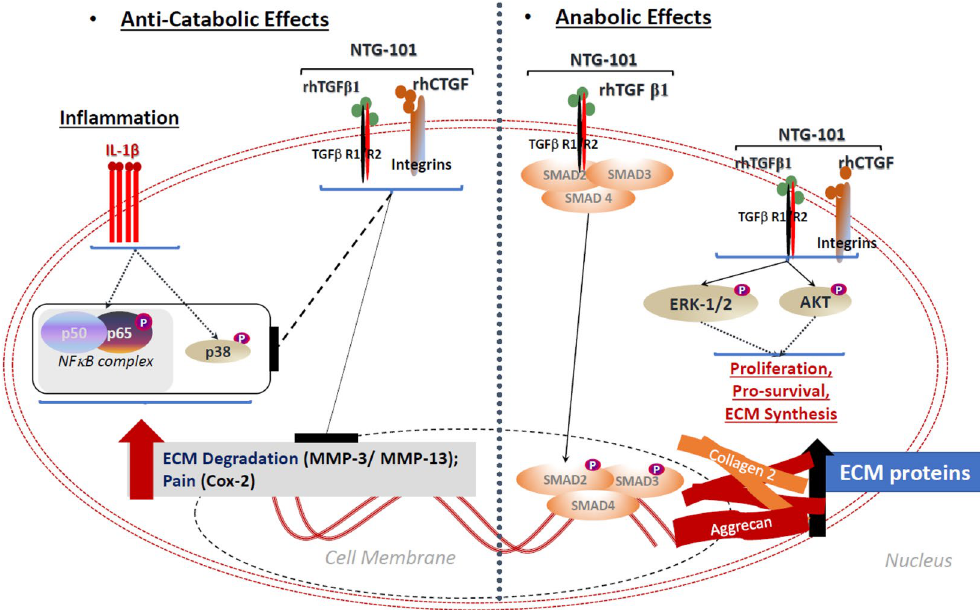
Figure 7. Model for mechanism of action (MoA) of NTG-101 in IVD-NP cells. Treatment with NTG-101 suppressed inflammation induced expression of matrix degrading enzymes (MMP-3. MMP-13), pain related enzyme, Cox-2 and expression of pro-inflammatory cytokines (IL-1β, IL-6 and IL-8) in rat, canine and human IVD NP cells in vitro and in vivo 27, 28 . Treatment with NTG-101 also suppressed phosphorylation of p38 and p65 subunit of NFκB complex, key regulators of inflammation in IVD-NP cells. Along with suppression of inflammation, NTG-101 also initiated ECM synthesis (Aggrecan, Col2A1), promoted cell survival and stemness in rat caudal IVD-NP post-injury. NTG-101 components, rhTGF-β1 and rhCTGF work synergistically under hypoxia resulting in regeneration of a degenerative disc. Combination of rhTGF-β1 and rhCTGF activates Smad-2/3 dependent signaling which regulate synthesis of GAG, PG and other important ECM molecules withing IVD-NP. Further, phosphorylation of Erk-1/2 (p42/44) and Akt in Smad-dependent or independent ways promote cell survival and proliferation in IVD-NP